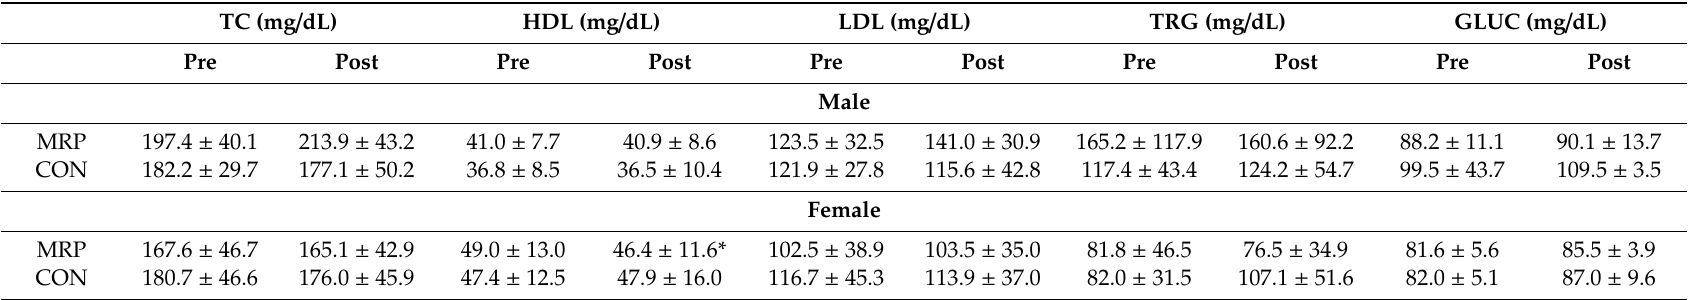
Table 2. Raw data for the blood variables for the meal replacement (MRP) and control (CON) groups for total cholesterol (TC), high-density lipoproteins (HDL), low-density lipoproteins (LDL), triglycerides (TRG), and glucose (GLU) from before (pre) and after (post) eight weeks of supplementation. Data is presented as mean ± standard